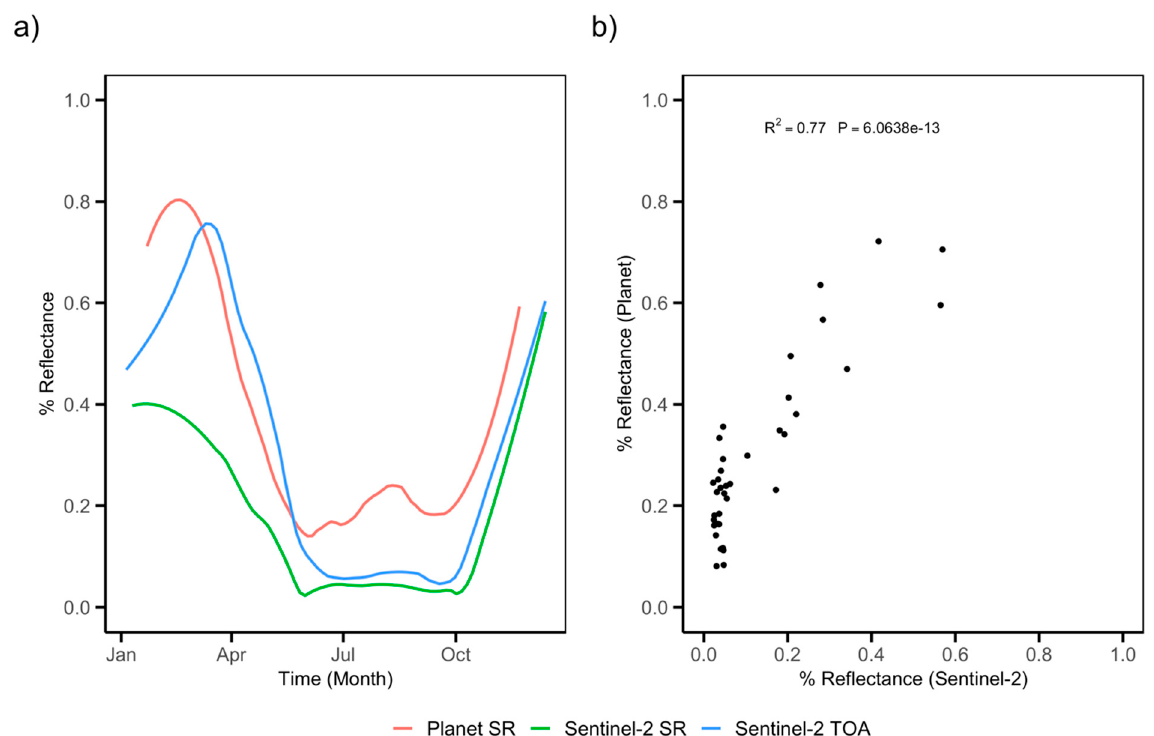
Figure 4. ( a ) Timeseries of site-averaged surface reflectance ( n = 35 lakes) in the green band for the 2019 period of overlap between Sentinel 2 Level 2A and PlanetScope. ( b ) PlanetScope surface reflectance (SR) shown relative to Sentinel 2 surface reflectance (SR) and top-of-the-atmosphere (TOA) in the green wavelengths. Data is shown as weekly averages to account for differences in overpass dates between Sentinel-2 and PlanetScope (y = 0.7x + 0.19, r 2 = 0.80) relative to Sentinel).